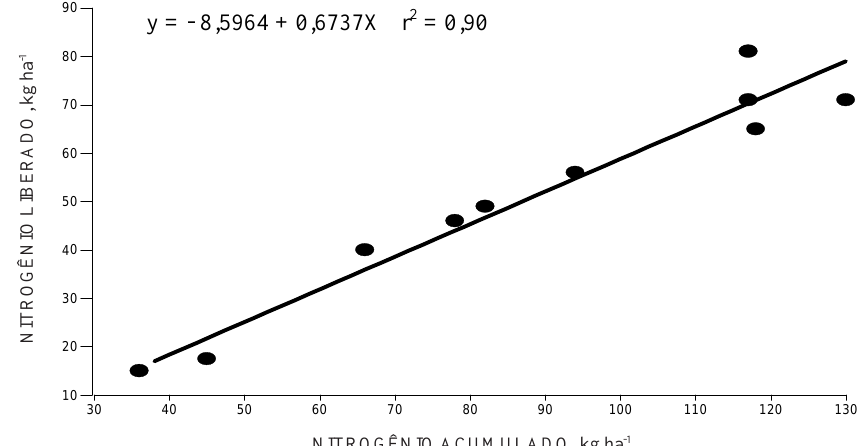
Figura 2. Relação entre o N acumulado na fitomassa das espécies de inverno na fase de florescimento pleno e o N liberado até 30 dias após o manejo nos anos agrícolas 1990/91 e 1991/92.